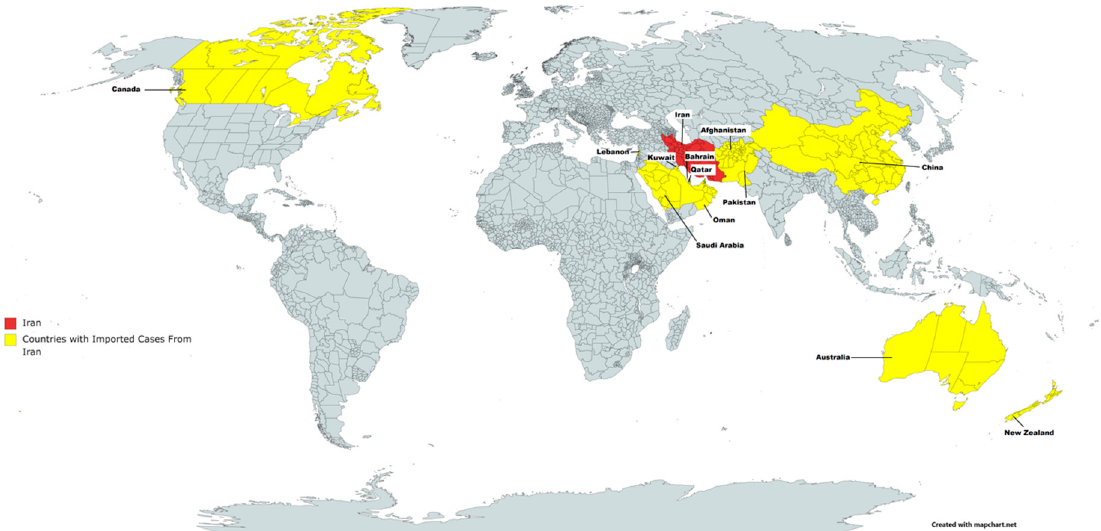
Figure 2. Map showing countries that had imported COVID-19 cases from Iran. The Islamic Republic of Iran is highlighted in red and countries with reported COVID-19 cases from Iran in yellow.